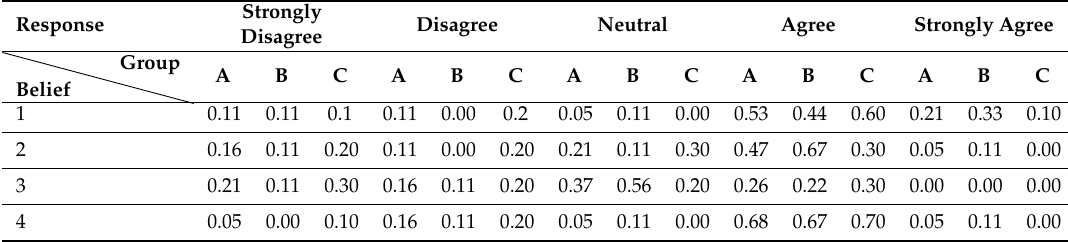
TableA2. Incidentcontrollerperceptionsandexpectationsacrosstheentiresampleandtheinjured / never been injured